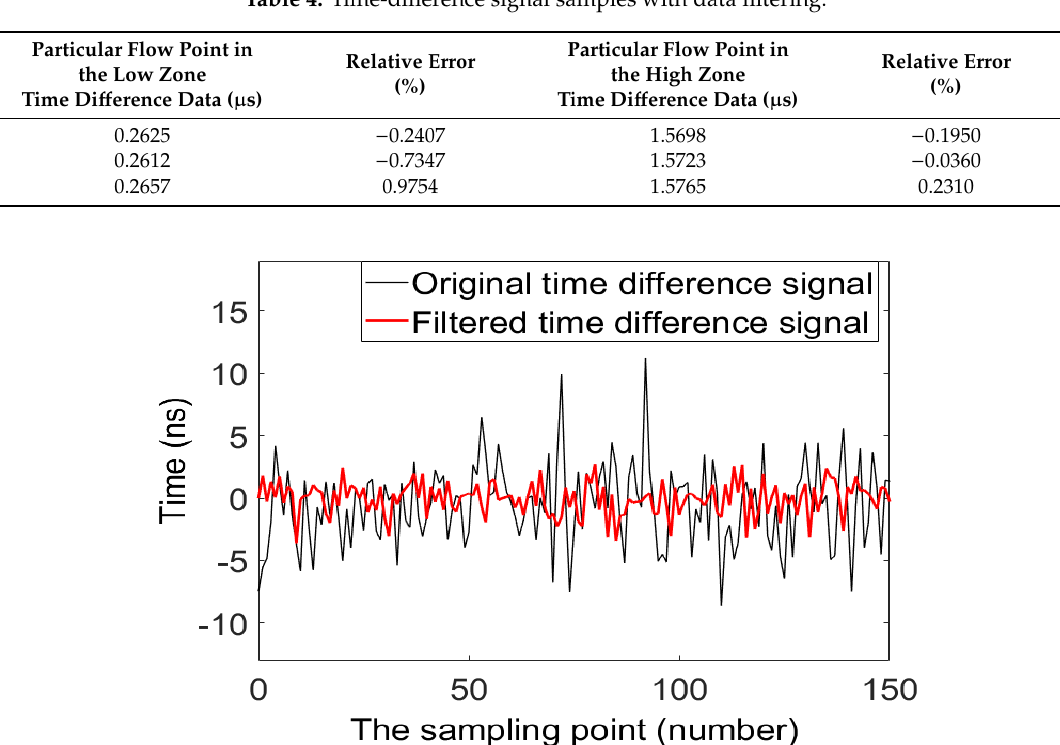
Table 4. Time-difference signal samples with data filtering. Table 4. Time-di ff erence signal samples with data filtering.